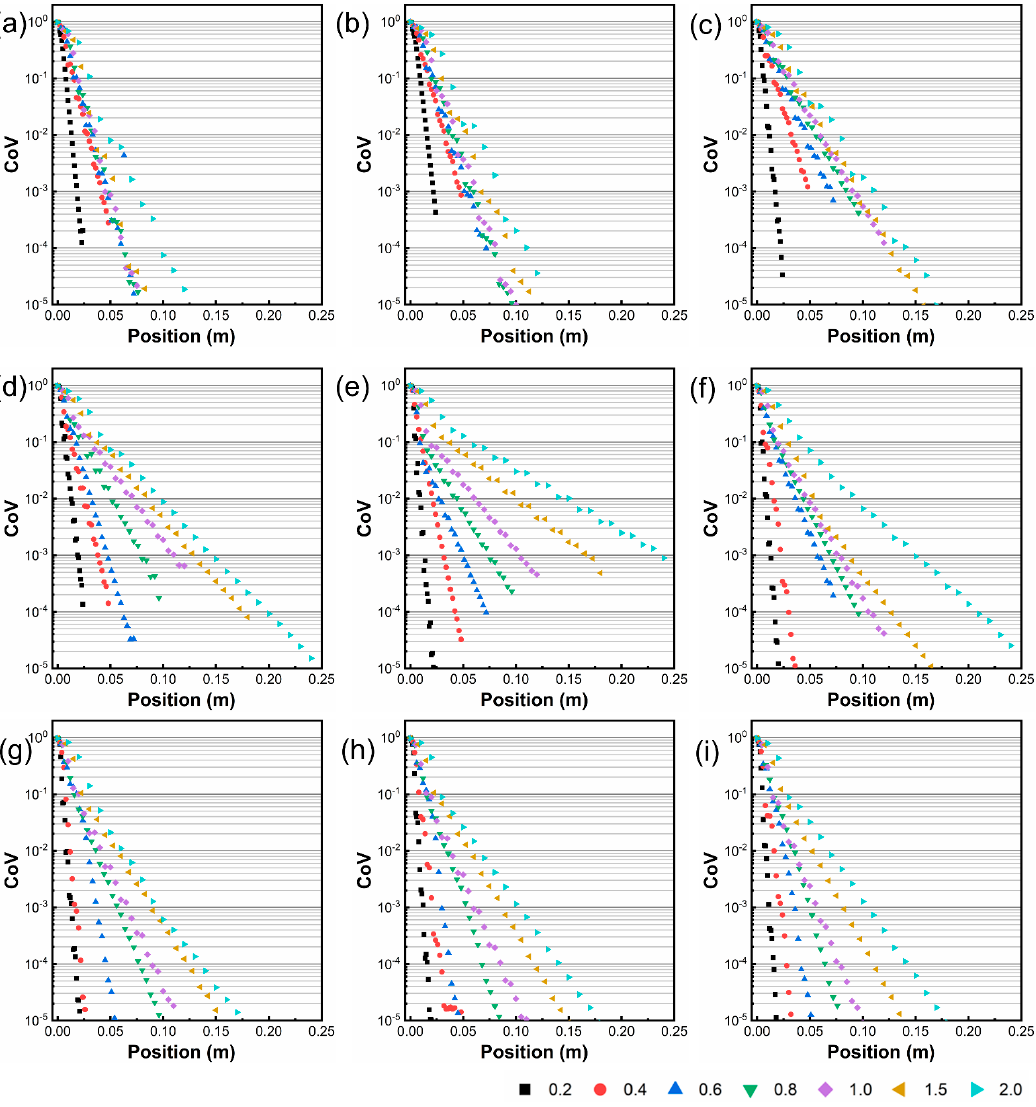
Figure 5. Effect of aspect ratio on CoV in axial position at ( a ) Re = 1; ( b ) Re = 5; ( c ) Re = 25; ( d ) Re = 50; ( e ) Re = 100; ( f ) Re = 200; ( g ) Re = 300; ( h ) Re = 400; ( i ) Re = 500.